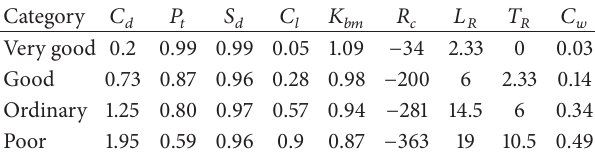
Table 6: Category center for durability evaluation.